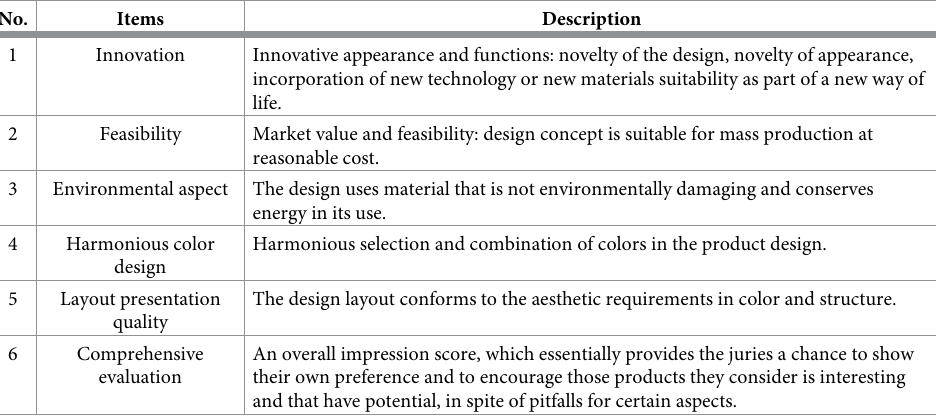
Table 4. Evaluation items for Electronic Home Applicants Design Awards and electronic tool design